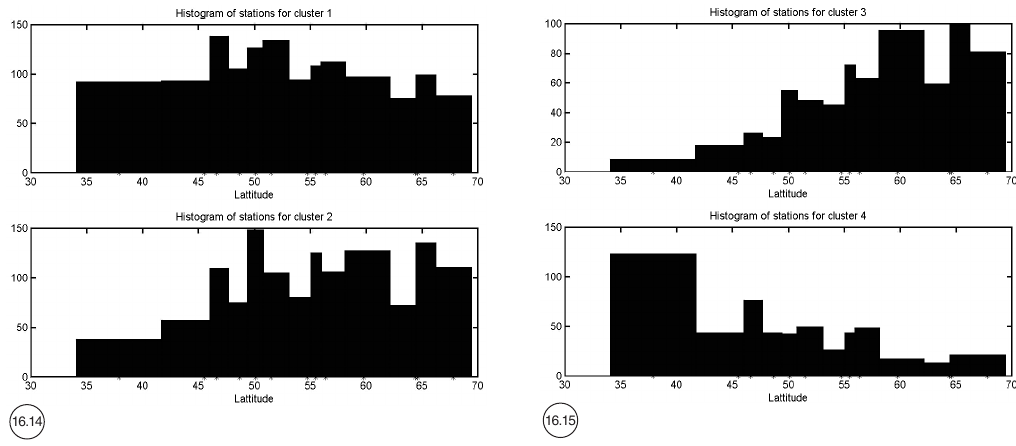
Fig. 16.14. Histogram of the stations from low latitude to mid and high latitude (37.9N to 67.8N), for Cluster 1 and Cluster 2. Fig. 16.15. Histogram of the stations from low latitude to mid and high latitude (37.9N to 67.8N), for Cluster 3 and Cluster 4.